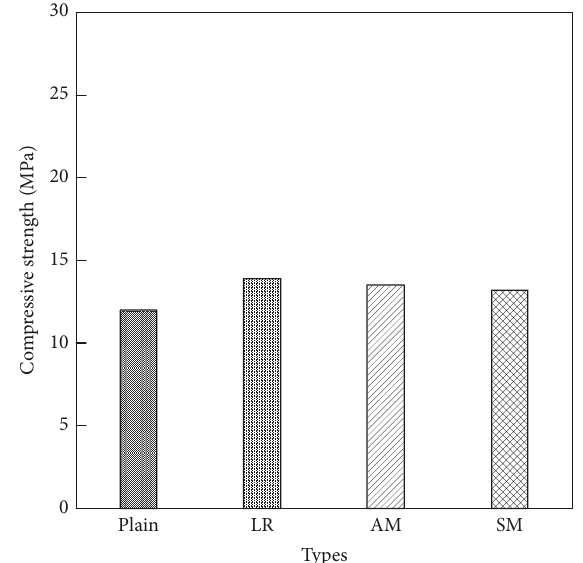
Figure 11: Compressive strength according to wall